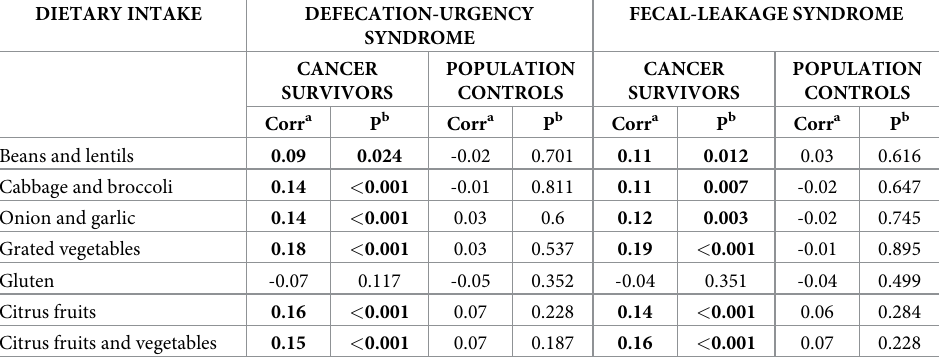
Table 2. Spearman correlation coefficient and corresponding P-values for the relationship between dietary intake and radiation-induced survivorship syndromes among gynecological cancer-survivors and population